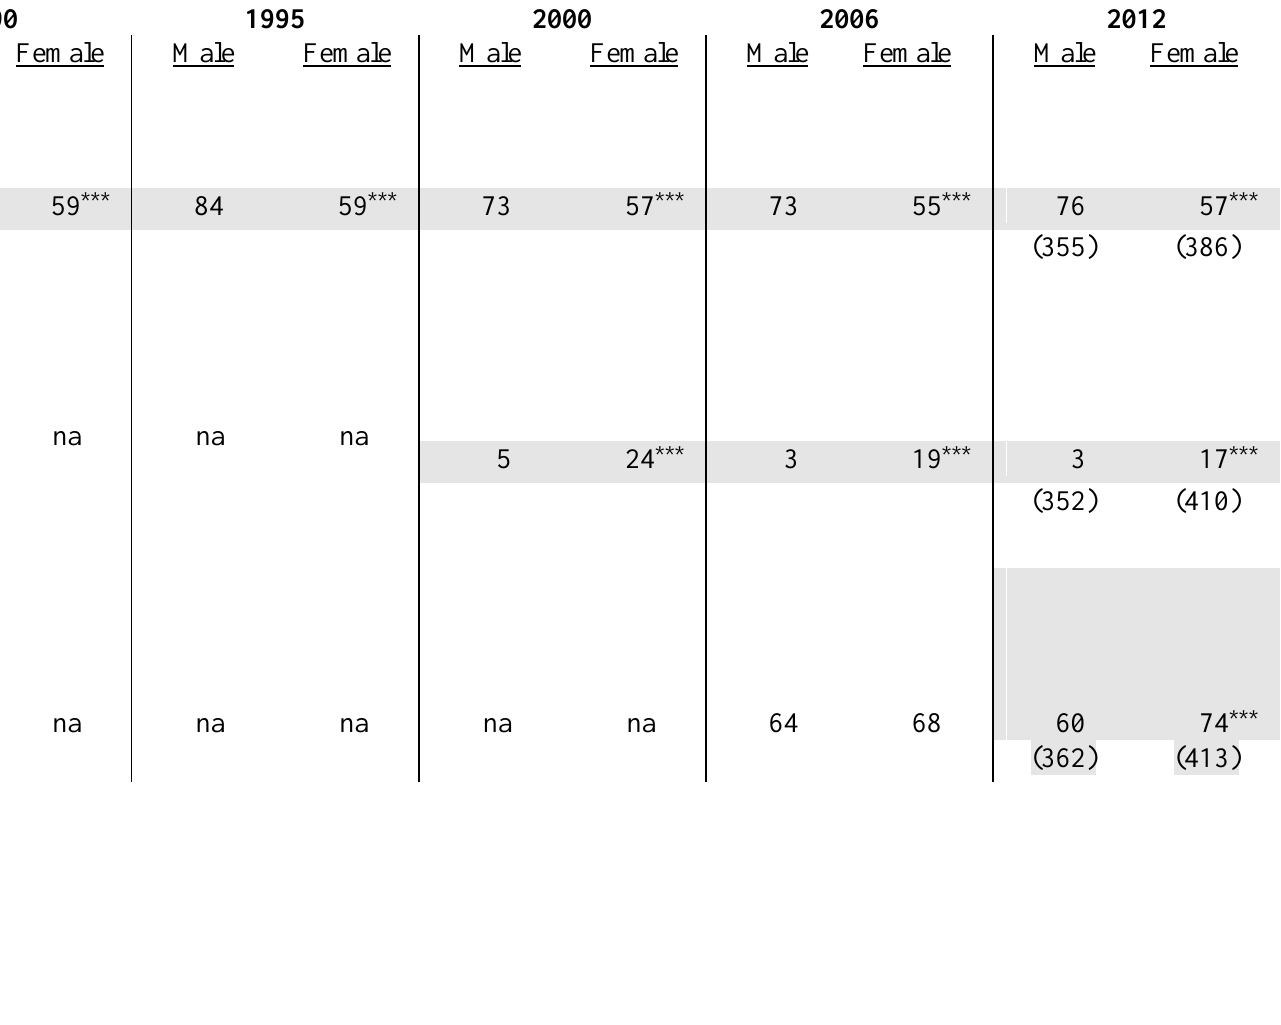
Table 31. Career Advancement Attitudes (percent agreeing or strongly